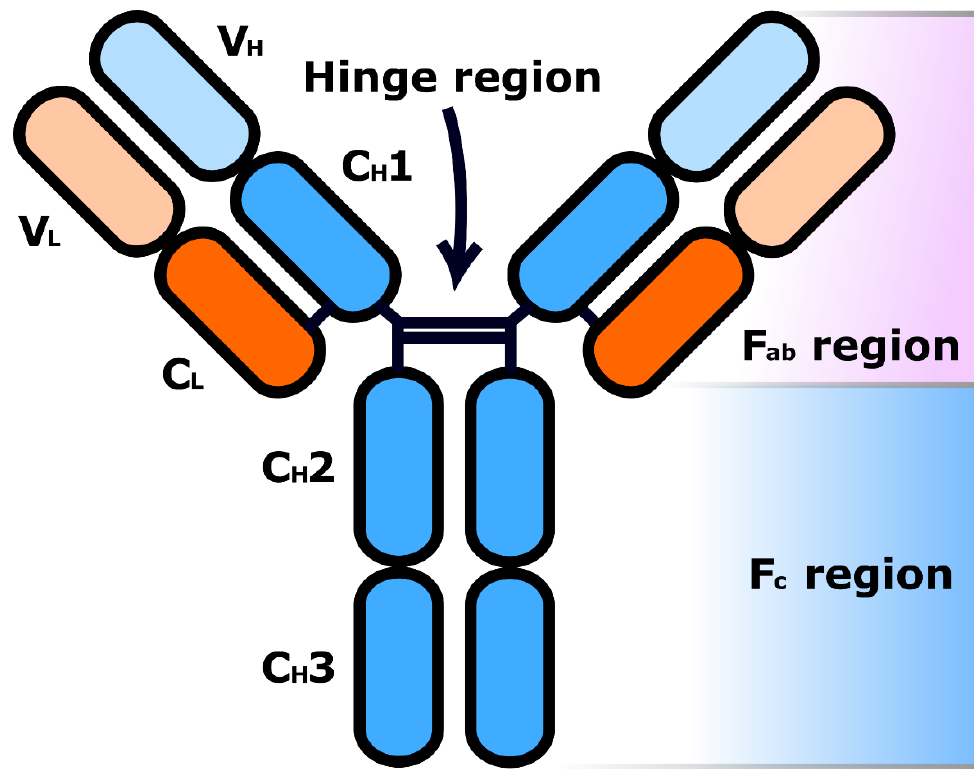
Figure 2. A general antibody structure (valency 2).